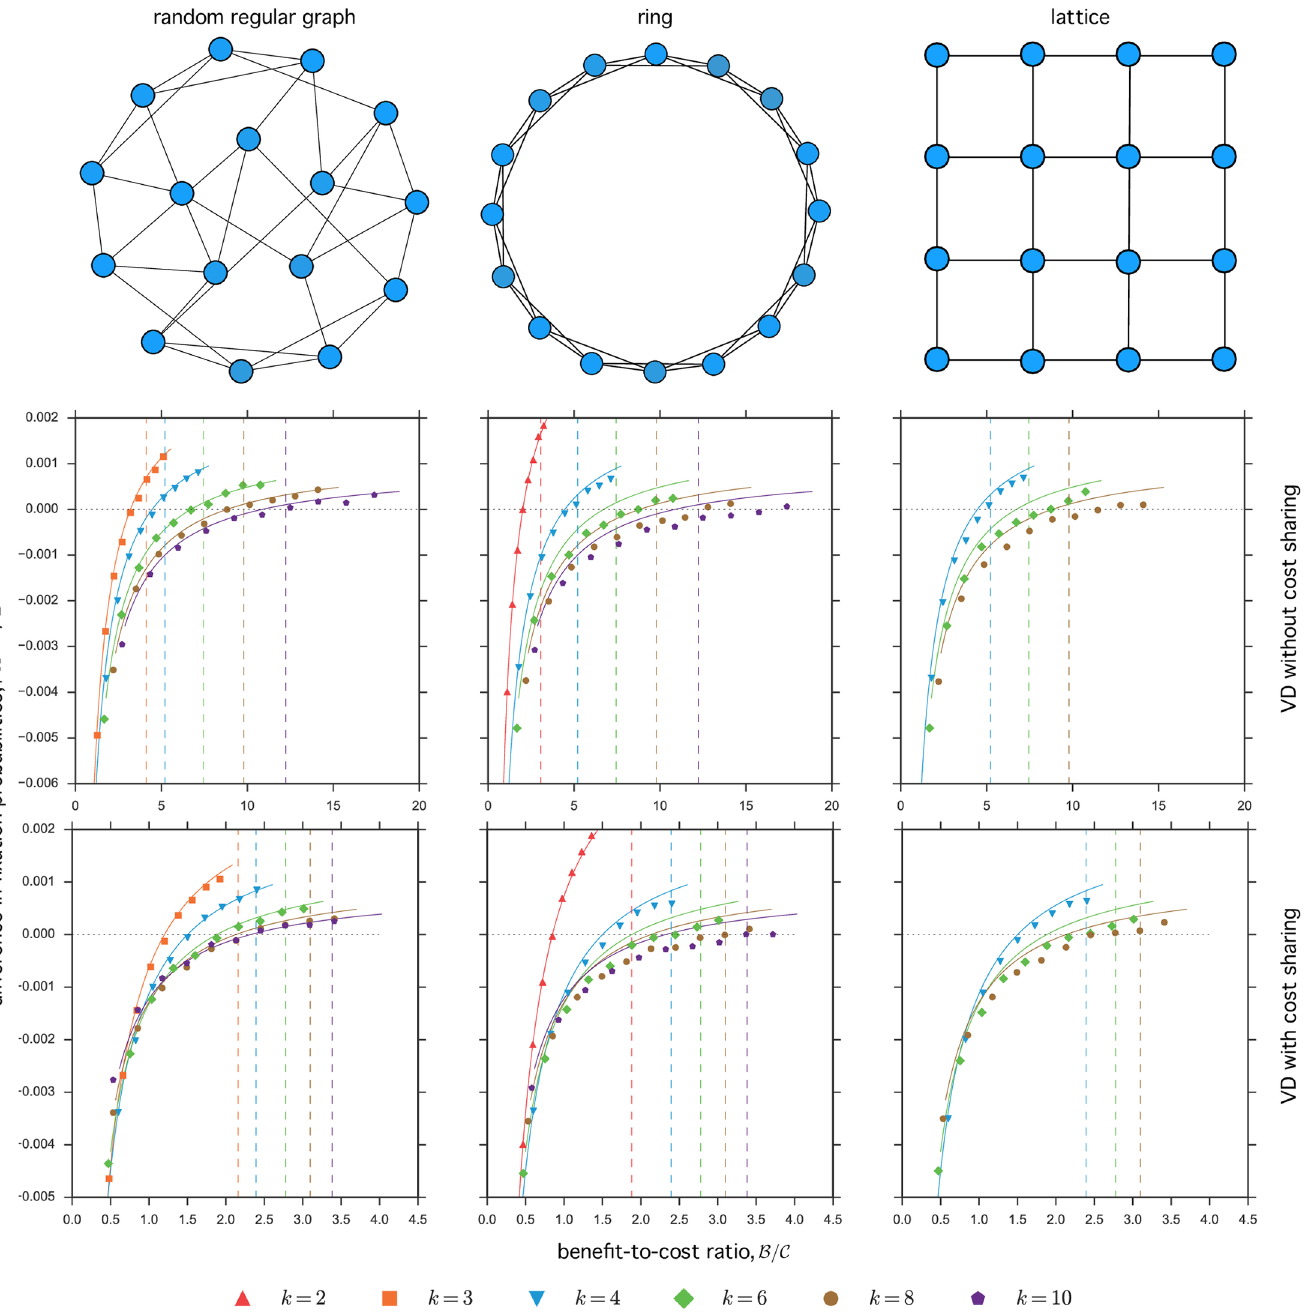
Fig 3. Simulations of evolutionary game dynamics on graphs (difference in fixation probabilities, N = 100). The first row shows the type of (regular) graph for the particular case of k = 4, i.e., each node has exactly four neighbors. The second and third rows show simulation results for the volunteer ’ s dilemma without cost-sharing and with cost-sharing, respectively. Simulation data in the first column correspond to random regular graphs, in the second column to rings, and in the third column to lattices. The fixation probability of cooperators, ρ A (defectors, ρ B ) was calculated as the fraction of runs where a single cooperator (defector) reached fixation out of 10 7 runs. Symbols show the difference between such fixation probabilities, as a function of the benefit- to-cost ratio B = C , for different types and degrees of the graph. Lines indicate analytical predictions for the difference in fi xation probabilities (left hand side of Eq (4) with normalized sigmas given by Eqs (6) or (8)). Dashed vertical lines the critical bene fi t-to-cost ratios B = C above which we have ρ A > ρ B for well- mixed populations (right hand side of Eqs (16) or (19) with normalized sigmas given by Eq (5)). Parameters: population size N = 100, intensity of selection w = 0.01, payoff cost C ¼ 1